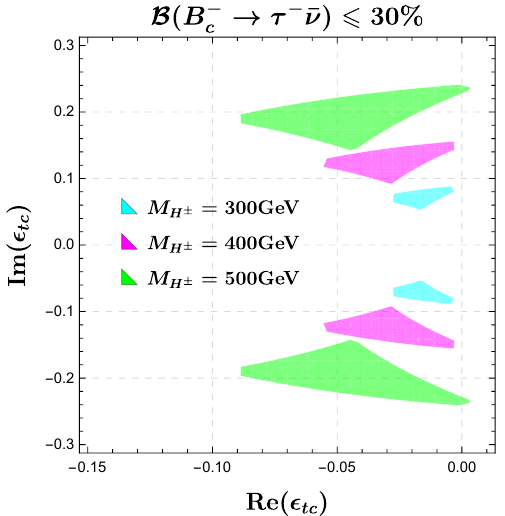
Figure 1 . The allowed regions of (cid:15) R results, under the constraint B ( B (cid:0) D ( (cid:3) ) masses and tan (cid:12) =